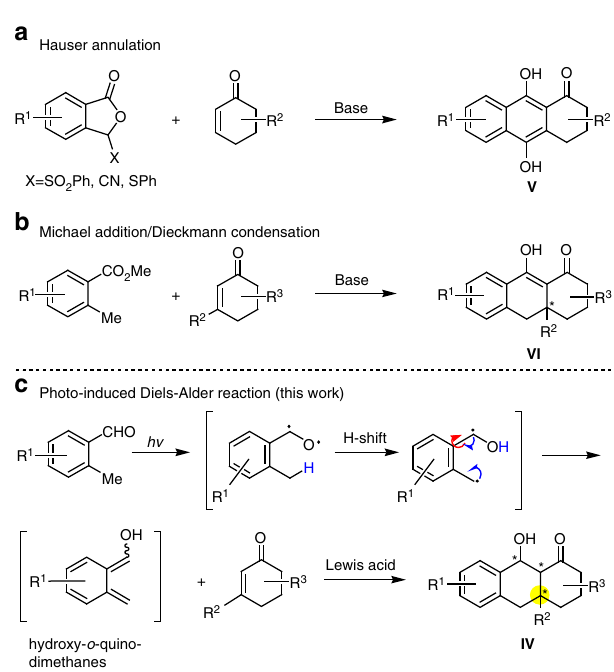
Fig. 2 Methods for generating core anthracenols and